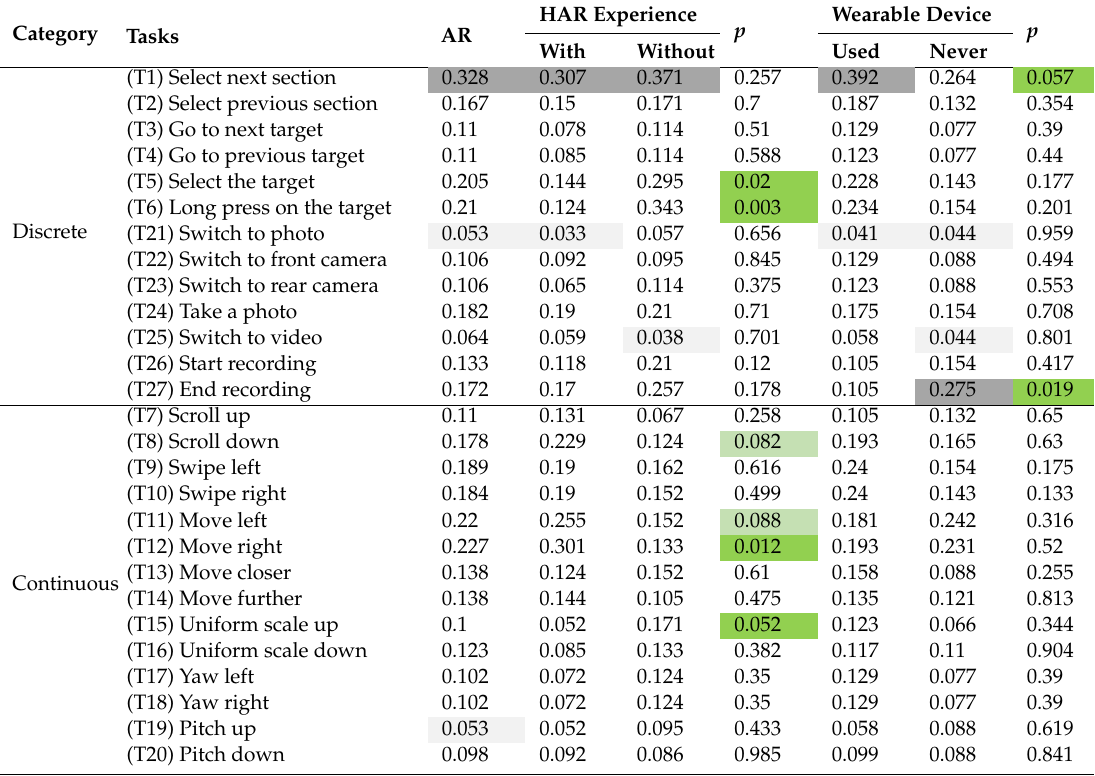
Table 2. Agreement rate for 27 tasks in two categories: discrete and continuous with e ff ects of users’ prior experience (experience with HAR application and using a wearable device). The highest agreement rates are highlighted in dark gray, while lowest are shown in light gray. Significance is highlighted in